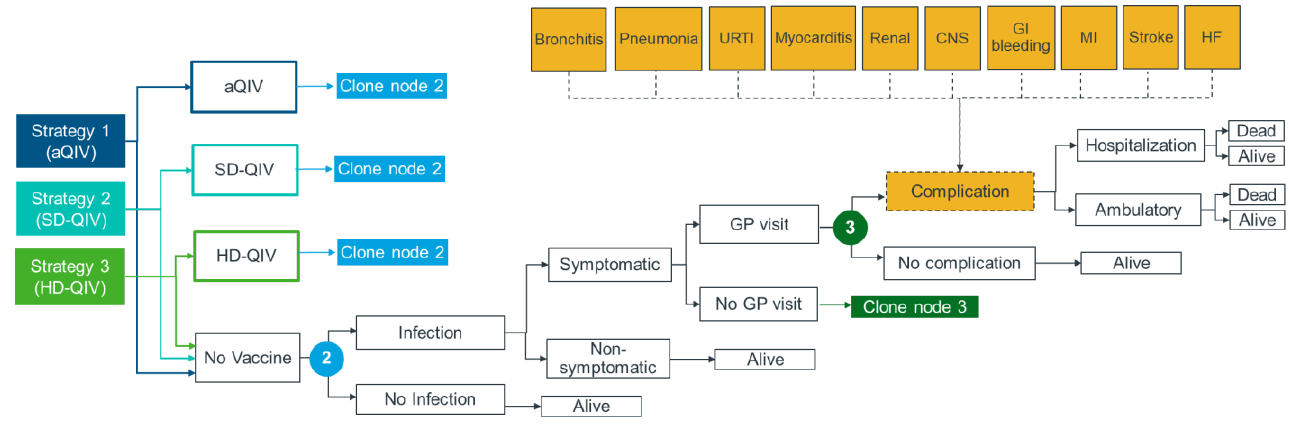
(Figure 1) captured key outcomes at different stages of influenza, including infection, developing symptoms, medical attention, developing IRCs, hospitalization, and death.